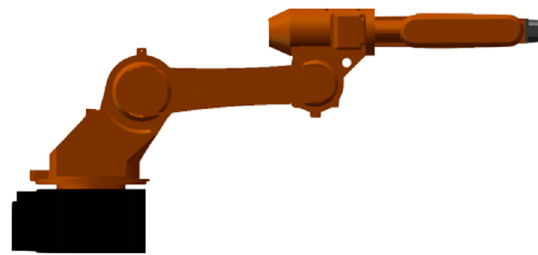
Figure 6. The most unfavorable working condition of the upper arm.